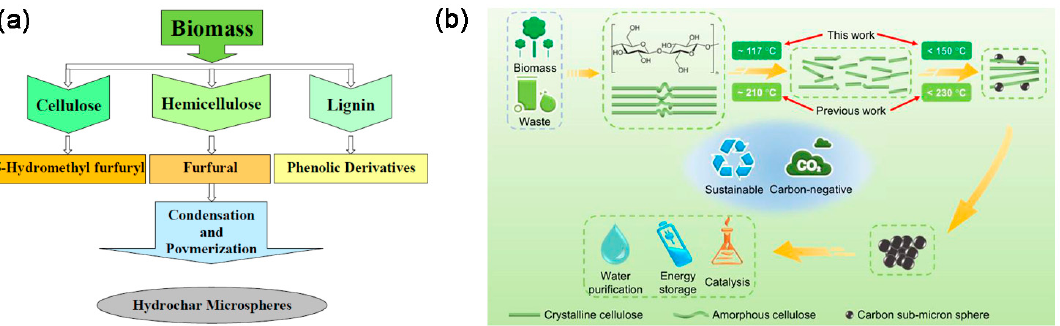
Figure 1. ( a ) Flowchart depicting hydrochar formation. Reprinted with permission from Ref. [20]. Copyright 2020 Springer Nature. ( b ) Schematic illustration of carbon sub-micron spheres from the low-temperature DTPH system of cellulose-based feedstocks. Reprinted with permission from Ref. [21]. Copyright 2022 Springer